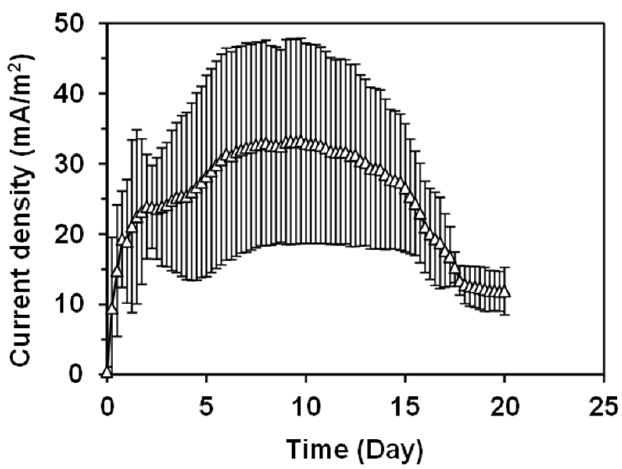
Figure 2. The current density of bMFC operation. S. oneidensis MR-1 served as the microorganism, and lactic acid served as the fuel. The bipolar membrane’s cation exchange layer and anion exchange layer were placed on the anode and cathode chamber sides, respectively. Iron (III) hydroxide was put onto the carbon plate. Both the anode and cathode chambers remained anaerobic.